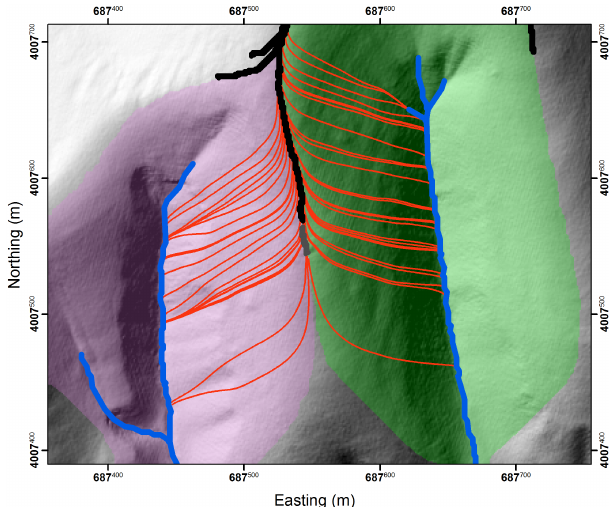
Figure 2. Map of a section of Gabilan Mesa, California (UTM Zone 10N), showing the examples of the spatial units used in the analysis of E ∗ R ∗ data. Two second-order basins, colored green and purple, are bisected by a ridge with two hilltop patches, a large black patch and a smaller grey patch. From these patches, representative hills- lope traces, outlined in red, travel down the hillslope and terminate at the channel network. Only 10% of the total traces generated for this ridge have been plotted and other surrounding hilltop patches and their associated traces are not displayed, to aid clarity. Coordi- nates are in